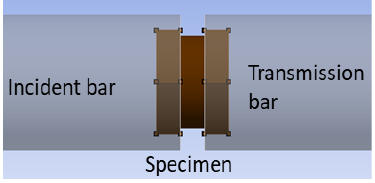
Fig. 3. Specimen gripped in hexagonal slots on